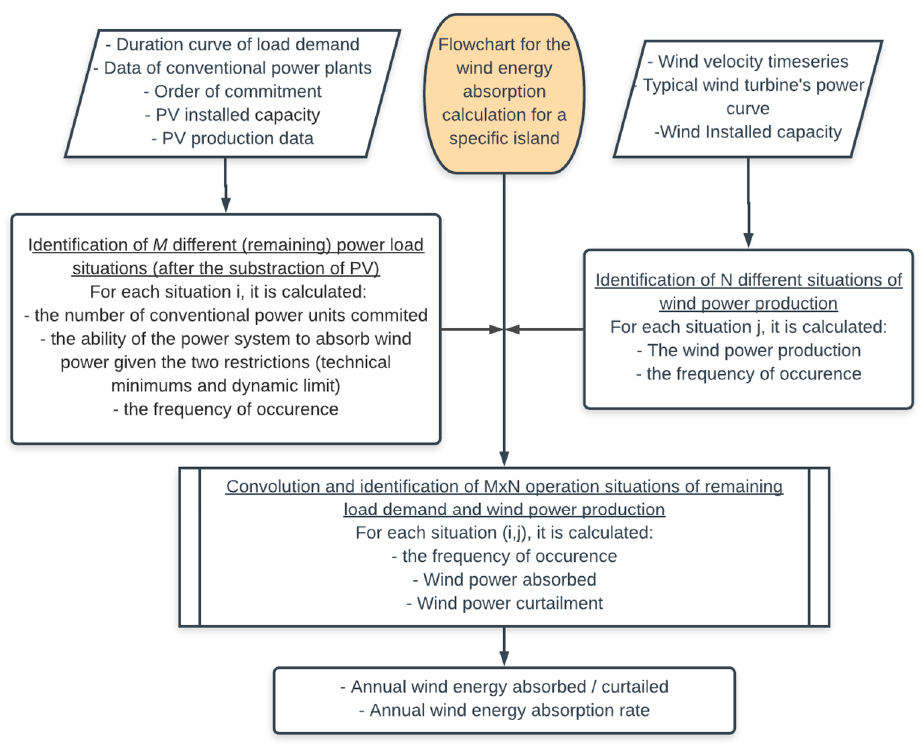
Figure 6. Flowchart of the probabilistic methodology for the calculation of wind energy absorption.